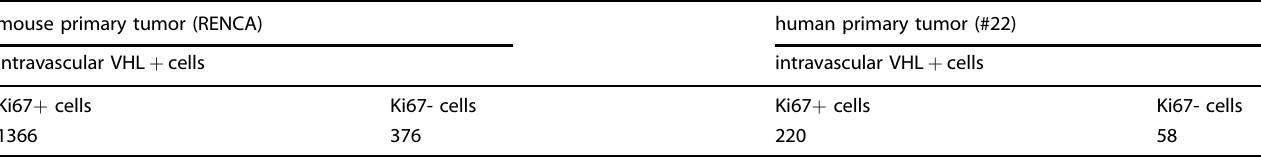
Table 3. Ki67 positivity in intravascular VHL + tumor cells (RENCA mixed tumor and human primary tumor, #22) mouse primary tumor